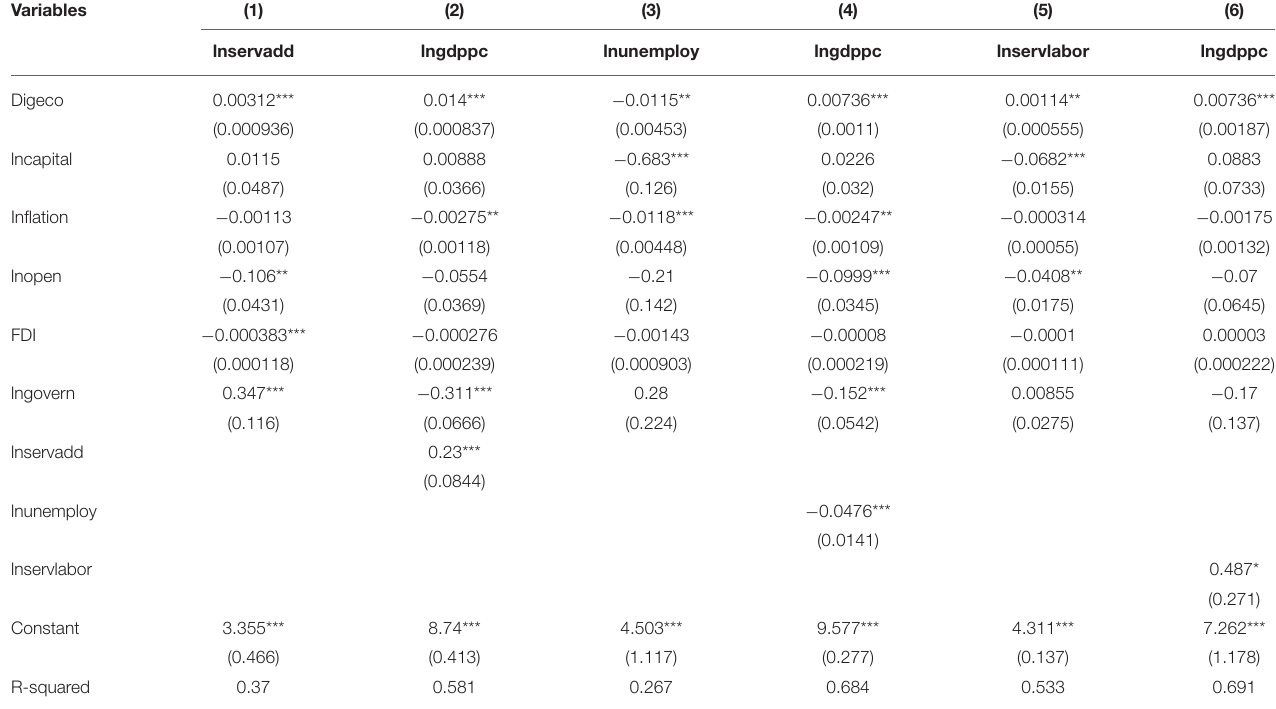
TABLE 6 | Test of mediating